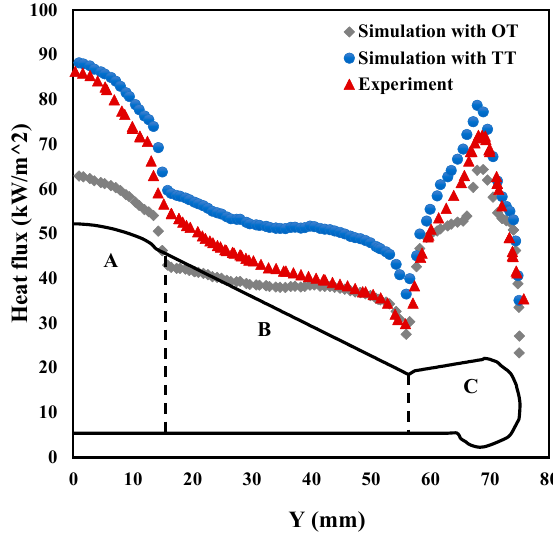
Figure 2. Heat flux simulation results of IRDT.